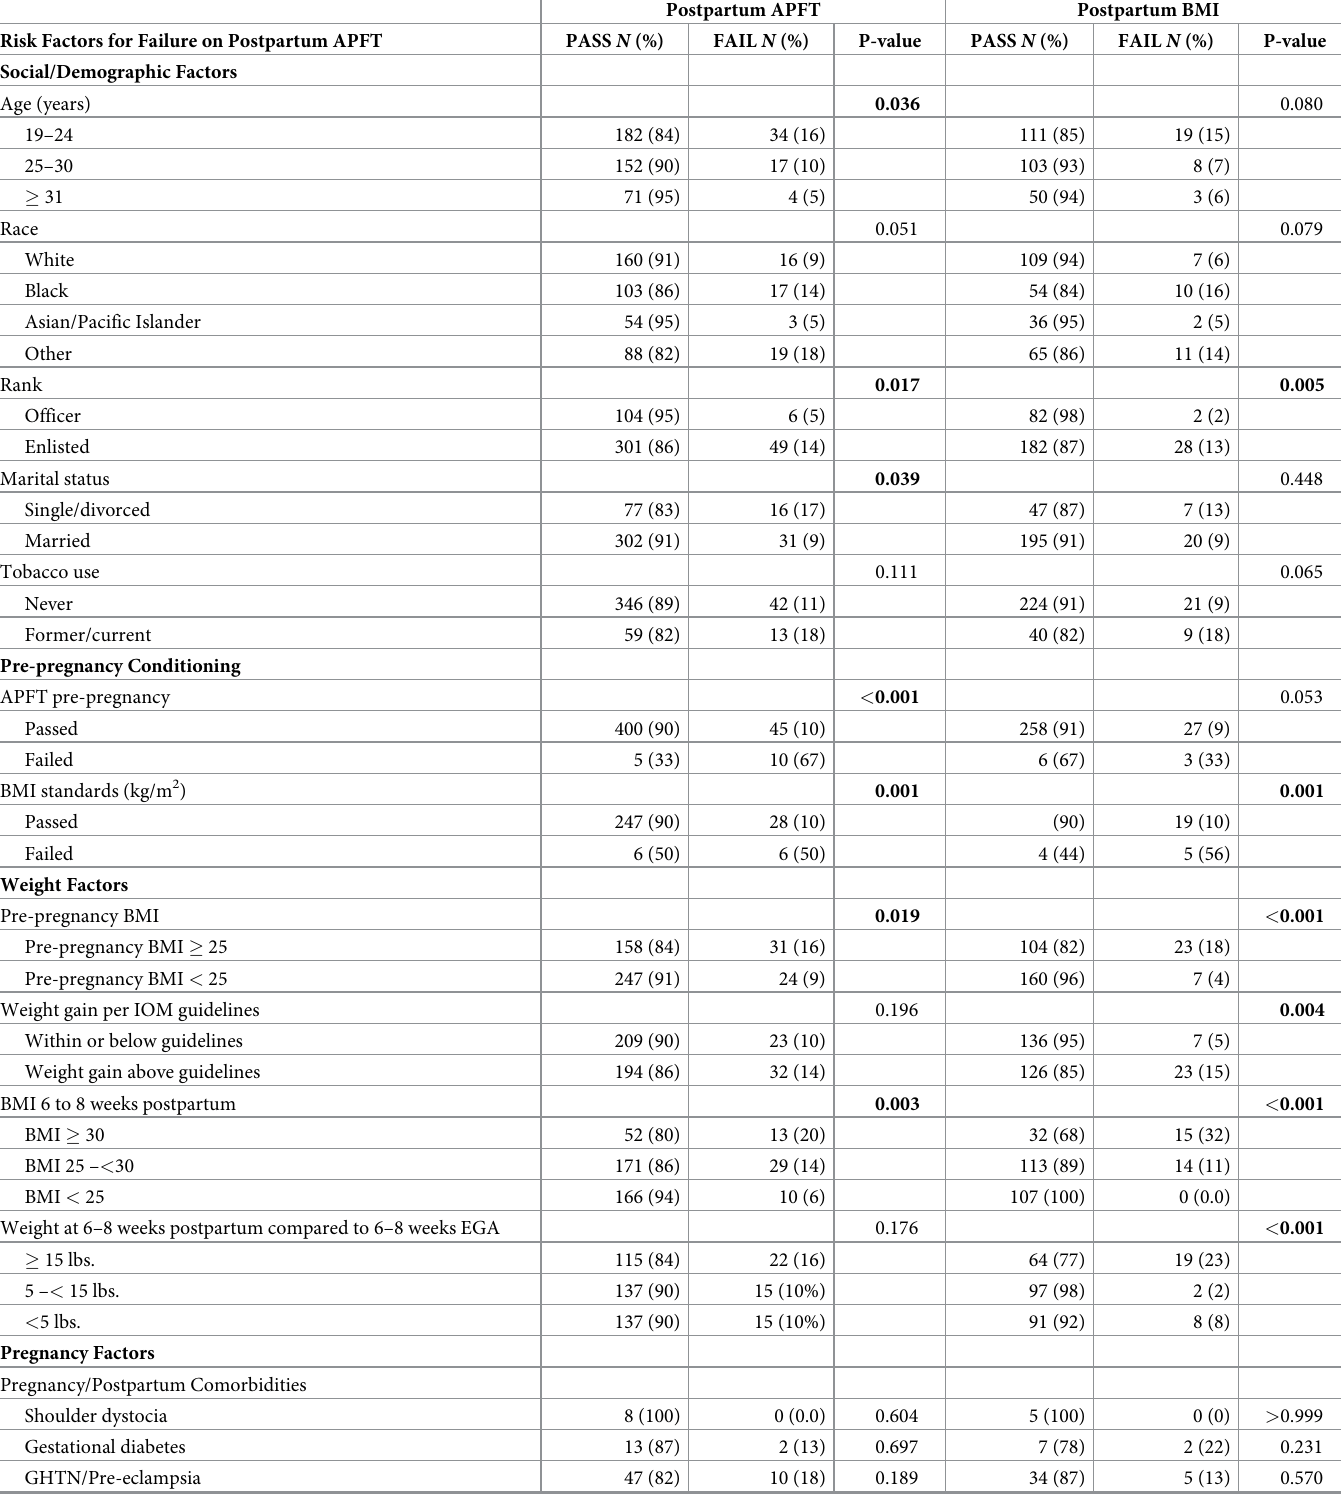
Table 4. Risk factors for failure on APFT and BMI